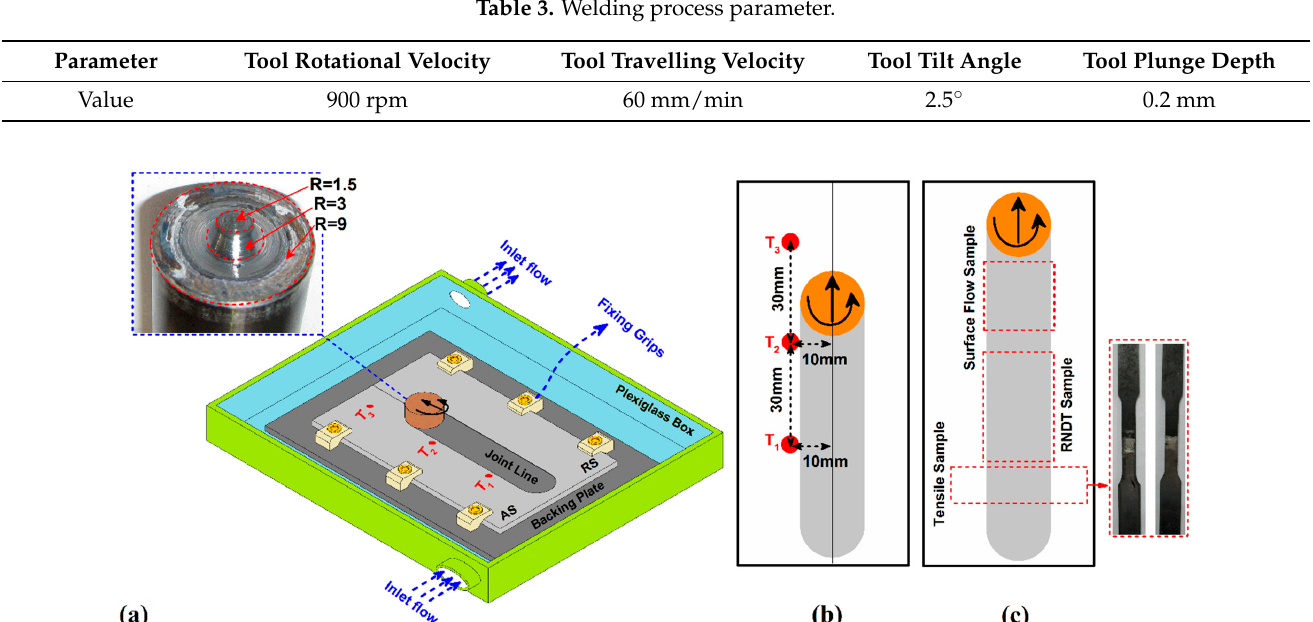
Figure 2. ( a ) Schematic view of welding setup, ( b ) thermocouples position, and ( c ) mechanical test